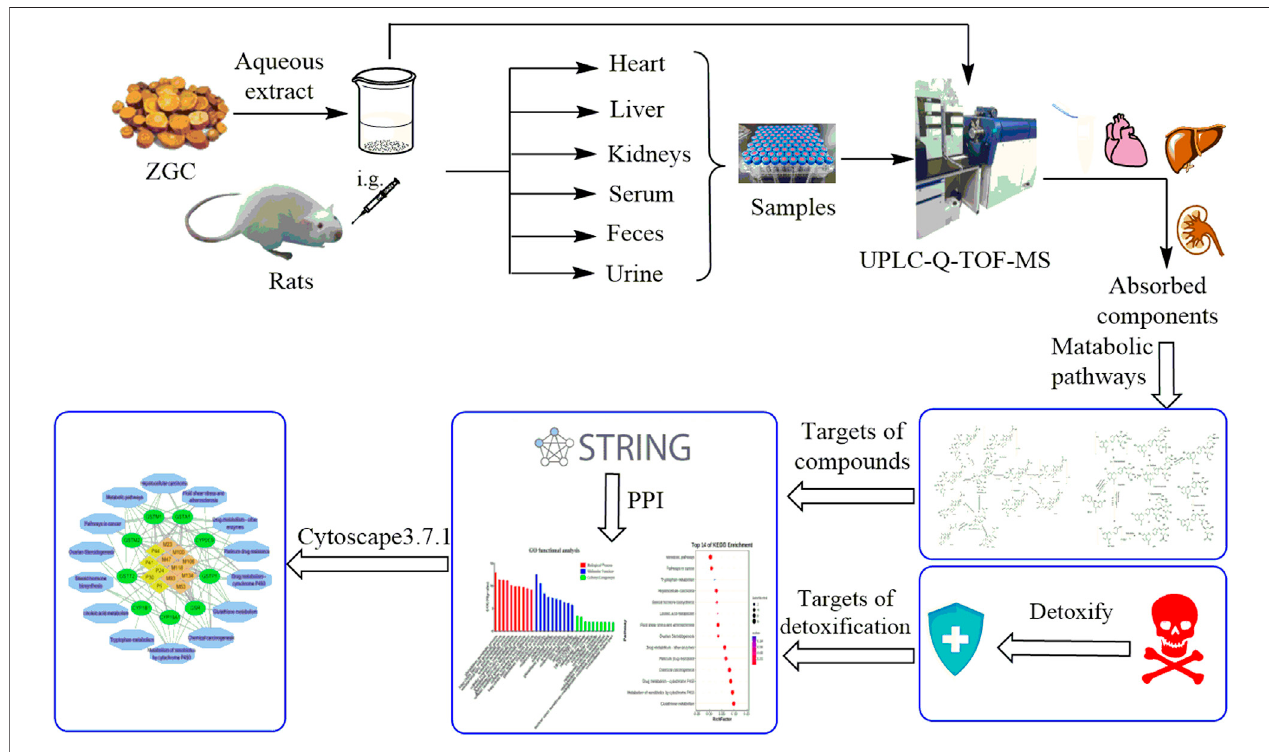
FIGURE 1 | Work fl ow for metabolic pro fi le and potential ingredients detoxi fi cation of ZGC.